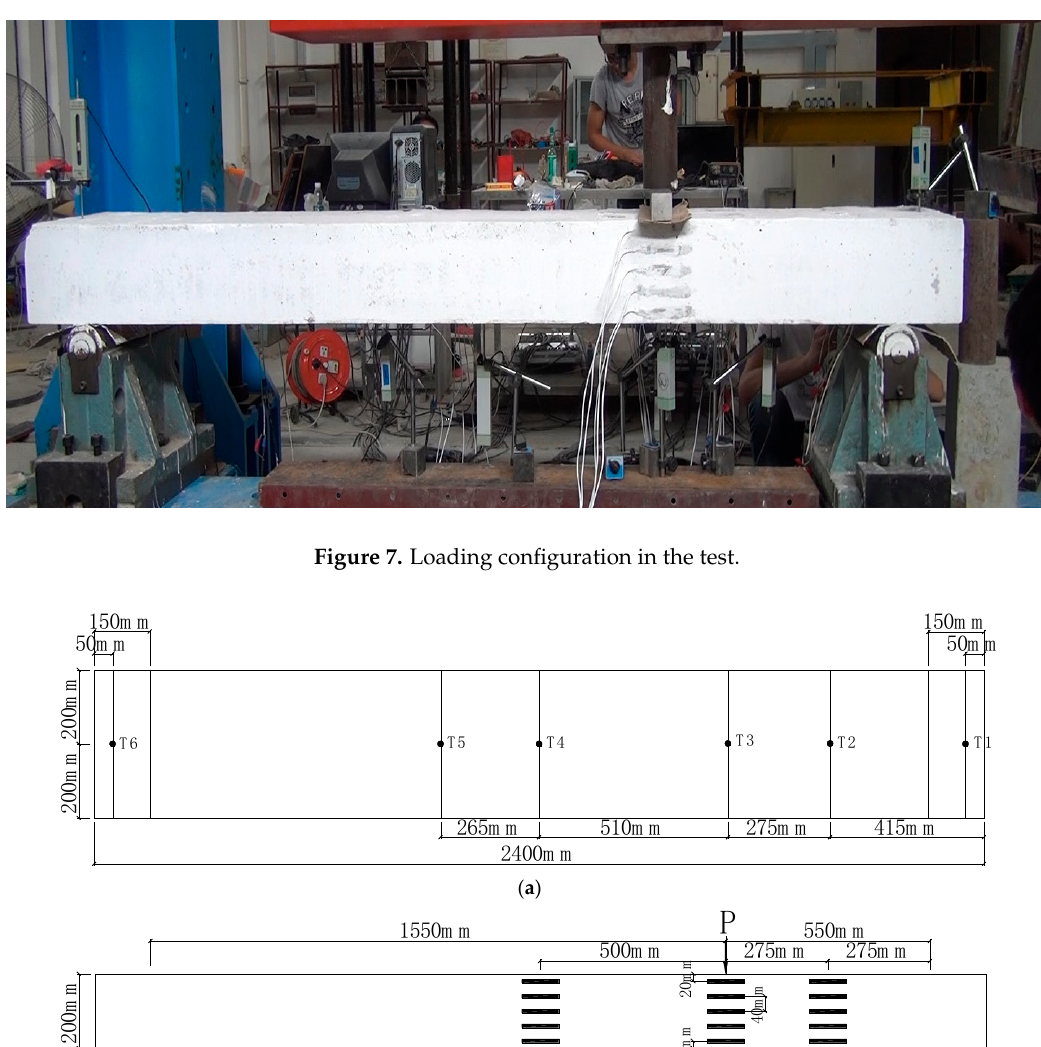
Figure 6. Details of invented drilling equipment: ( a ) Vertical drilling; ( b ) Inclined drilling; ( c ) Drilling equipment.